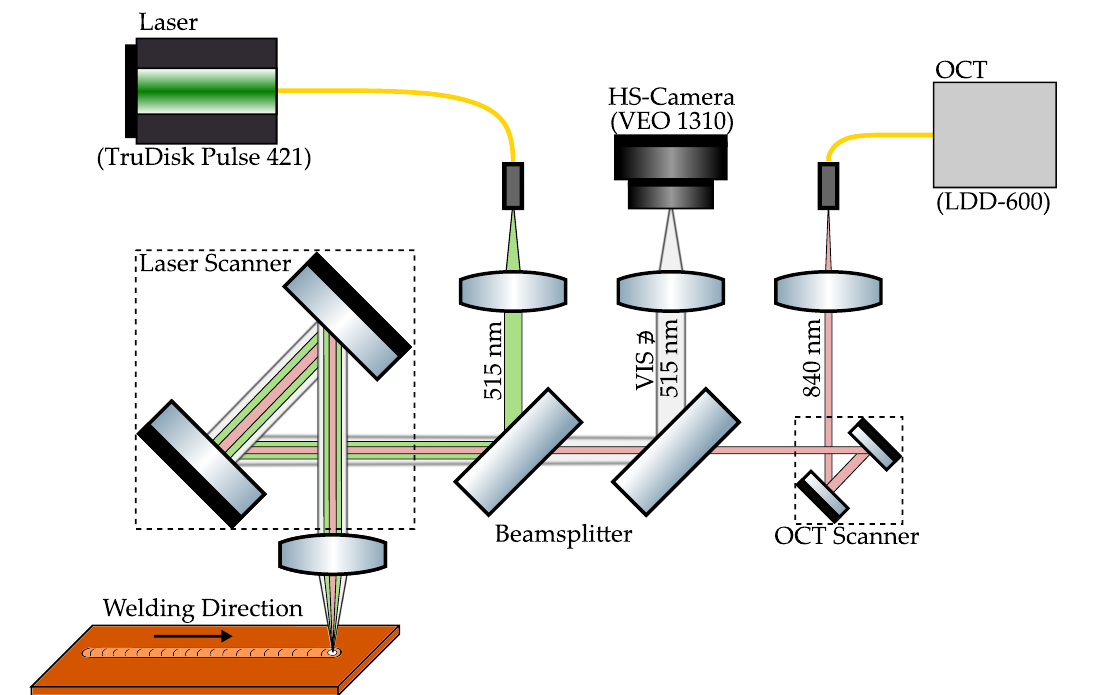
Figure 1. Schematic illustration of the experimental setup; green beam: laser beam (515nm), grey beam: imaging path (VIS 515 nm), light red beam: OCT beam (cid:54)(cid:51)